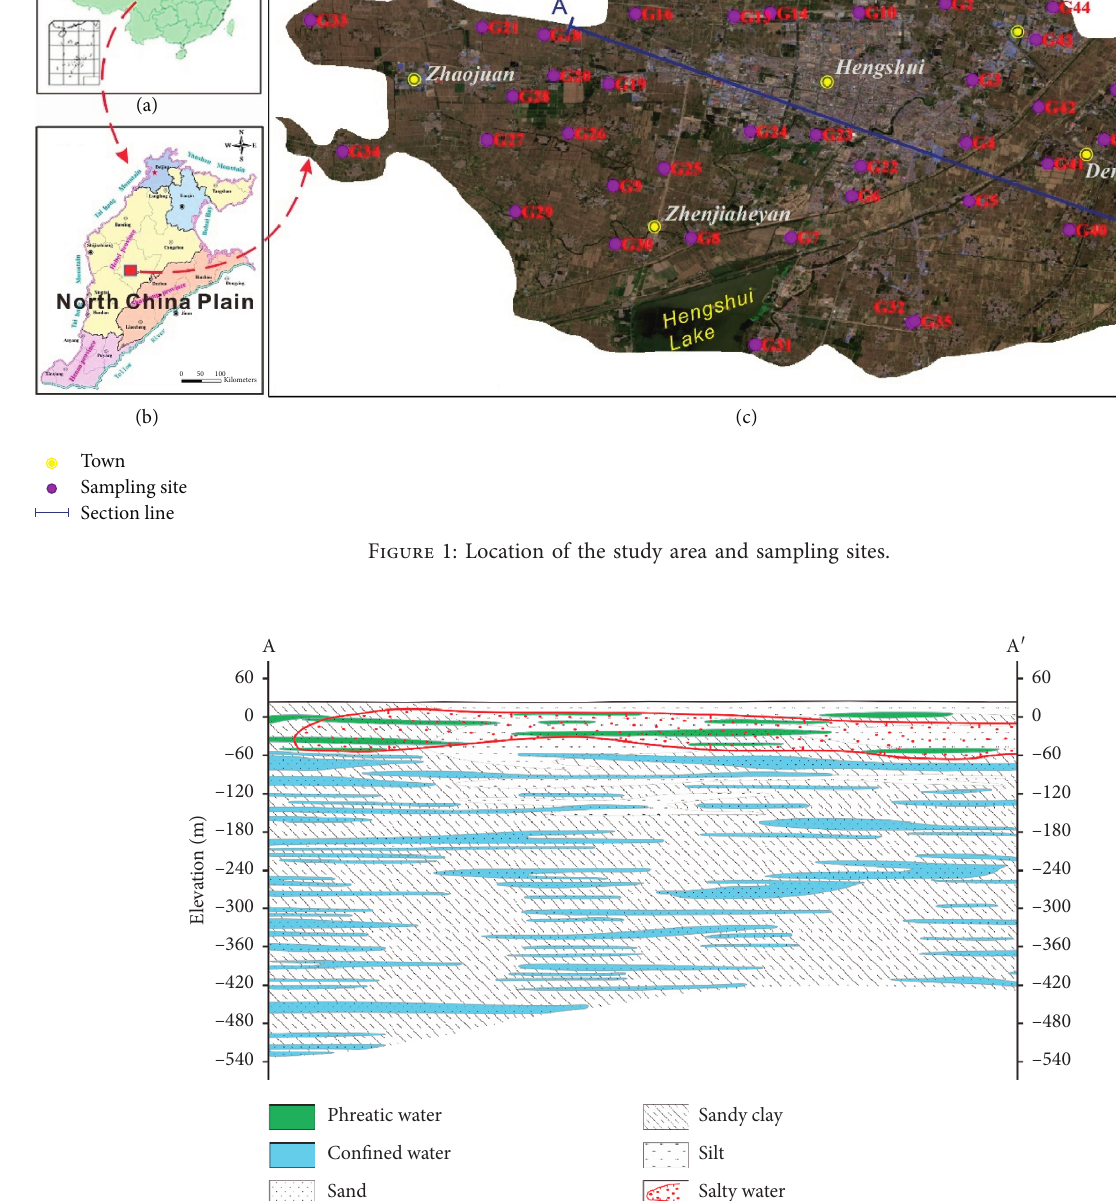
Figure 2: The hydrogeological cross section along the